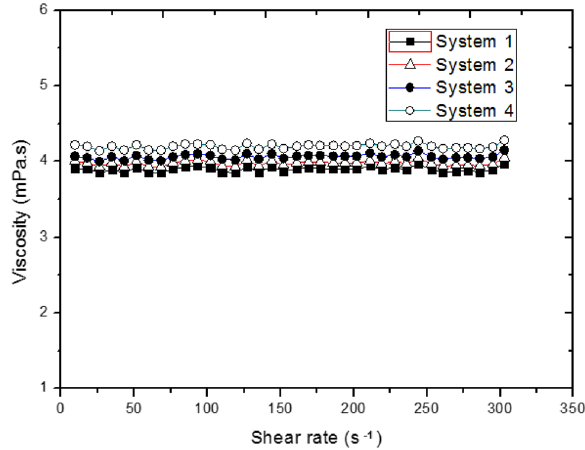
Fig. 5 Viscosity as a function of shear rate of microemulsion